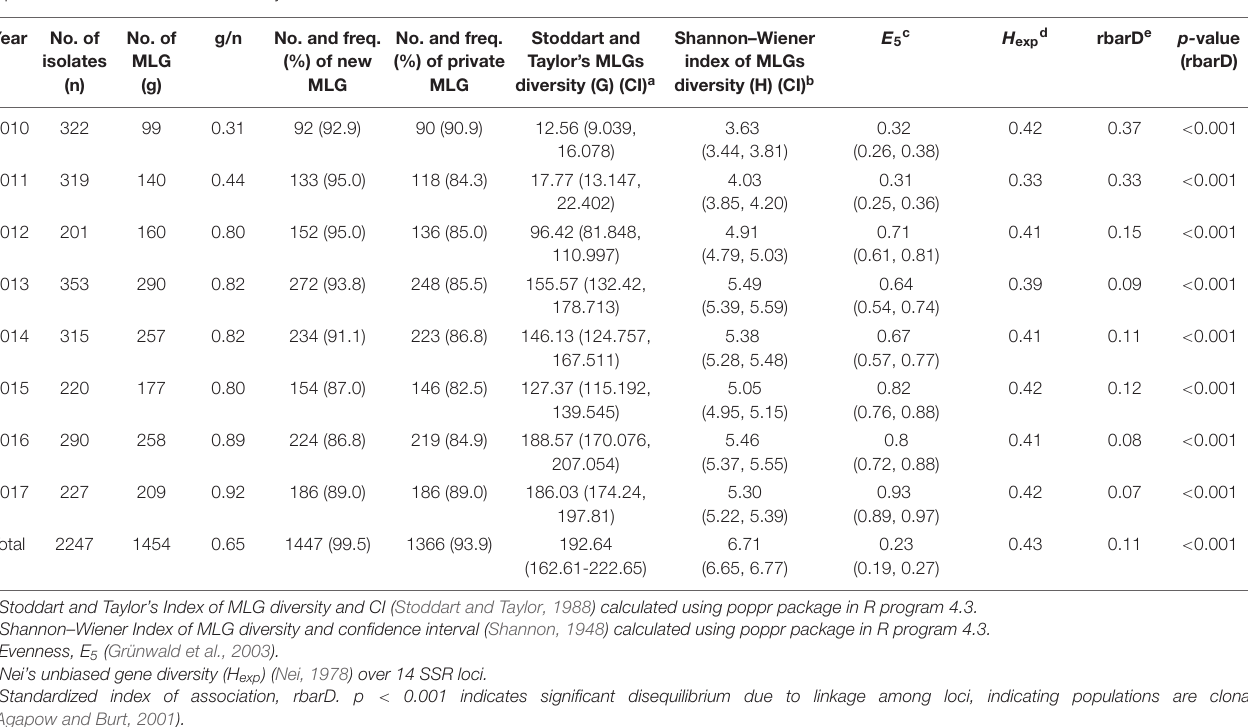
TABLE 3 | Numbers of Puccinia striiformis f. sp. tritici isolates, numbers of multilocus genotypes (MLGs), numbers and frequencies (%) of new and private MLGs, Stoddart and Taylor’s MLG diversity (G) values and confidence intervals (CIs), Shannon–Wiener index values of MLG diversity (H) and confident intervals (CIs), evenness